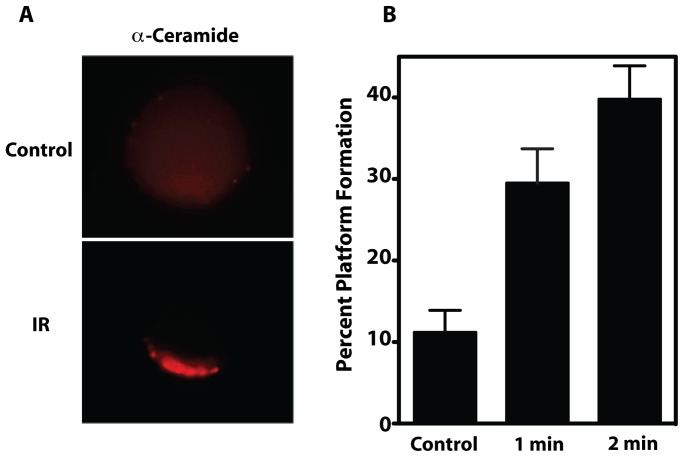
IR induces CRP formation on the surface of purified tumor endothelium.(A) Representative image of the clustering of ceramide into platforms on the outer leaflet of the plasma membrane of purified tumor endothelial cells at 1 min post 15 Gy. For these studies, irradiated cells were stained with Texas Red-labeled anti-ceramide antibody, and platforms identified as in Materials and Methods. Images are representative of over 30% of cells from 3 experiments in which over 100 cells were analyzed. (B) Time-dependent generation of platforms in tumor endothelial cells. CRPs in tumor endothelial cells irradiated ex vivo with 15 Gy were quantified as in Materials and Methods. Data (mean ± 95% CI) are collated from 3 experiments in which 200 cells were analyzed per point.